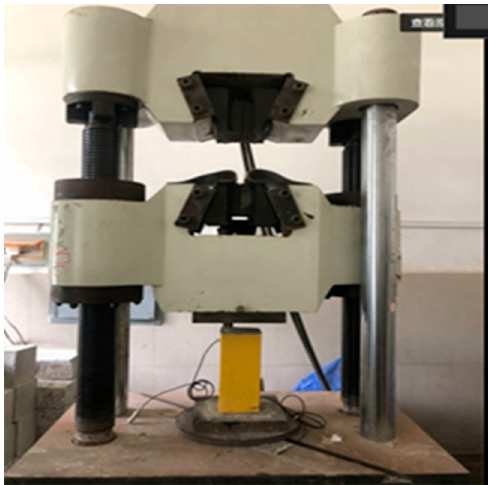
Figure 6. Loading device.